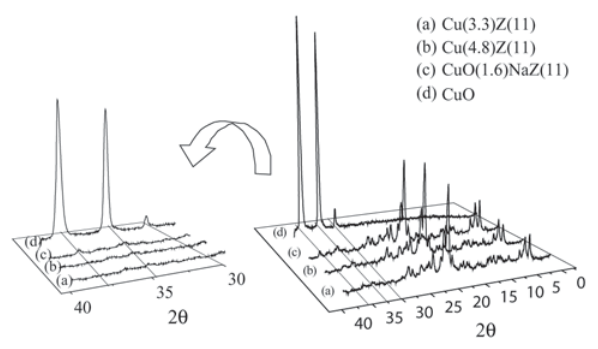
Figure 1. XRD patterns of Cu(X)/Z(11) catalysts, CuO/Na/ZSM-5 and CuO.